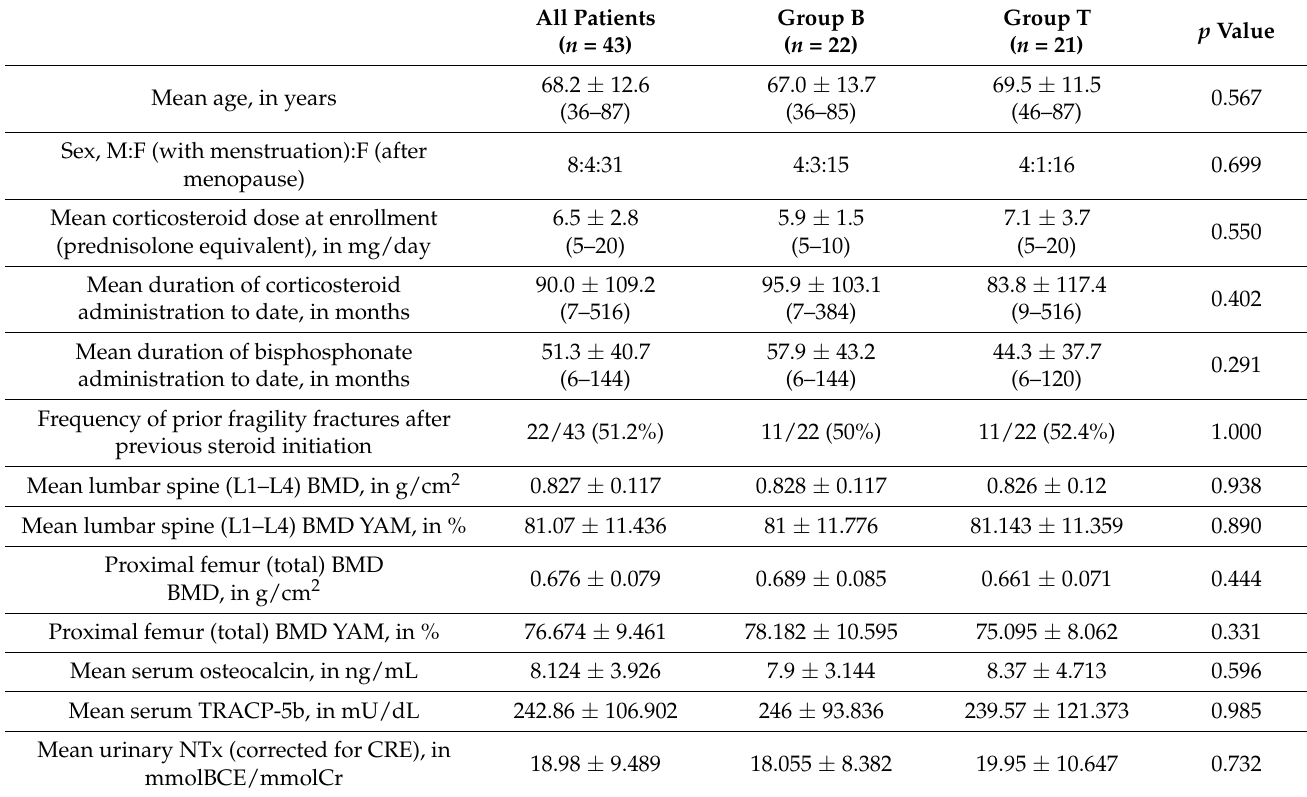
Table 1. Patients’ characteristics at baseline.